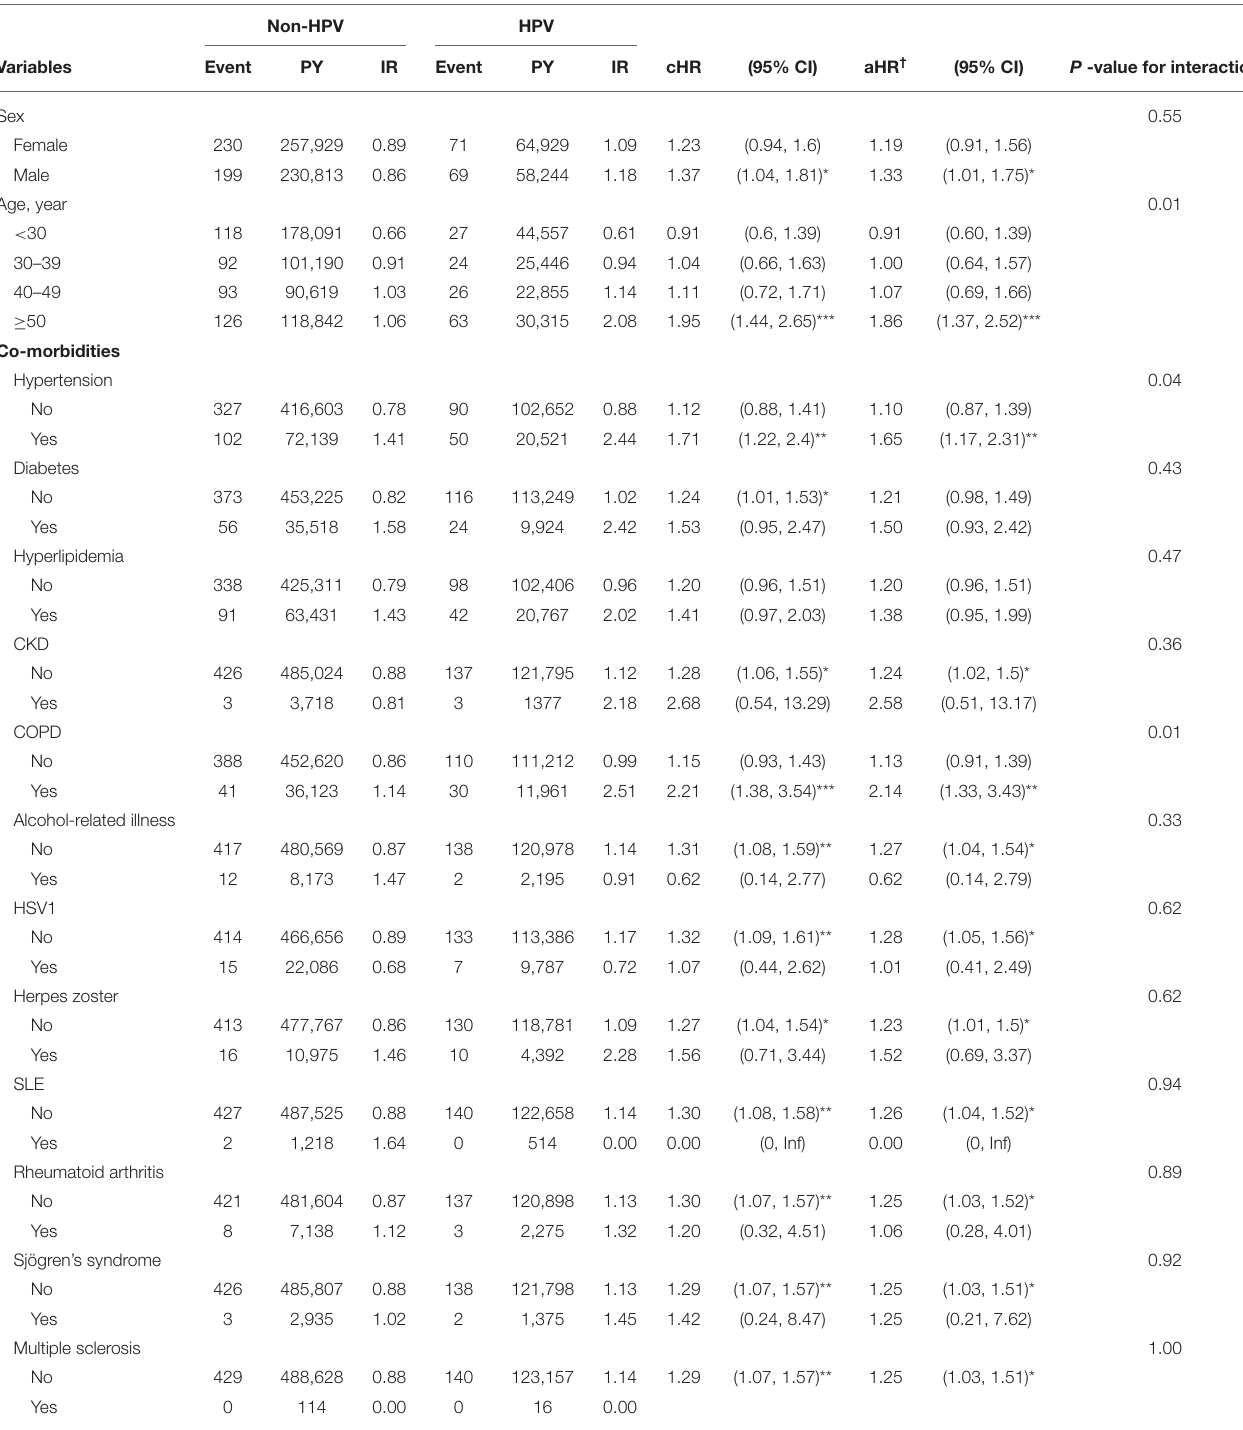
TABLE 3 | Subgroup